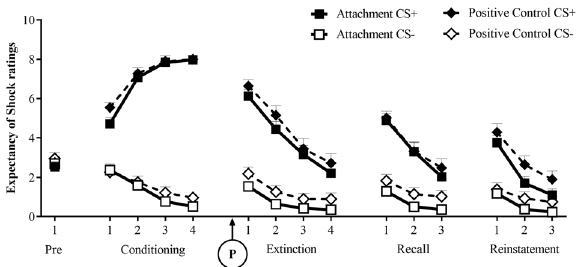
Fig. 3 Subjective ratings of expectancy of shock (mean scores + SEMs to the CS + and CS − ) during pre-conditioning, conditioning, extinction, extinction recall and reinstatement phases, respec- tively. Note expectancy scores are averaged across groups of 4 trials. The experimental manipulation, receiving the attachment or positive control imagery task, was delivered immediately prior to the extinction phase ( ‘ P ’ on the graph). Groups did not signi fi cantly differ in their level of expectancy of